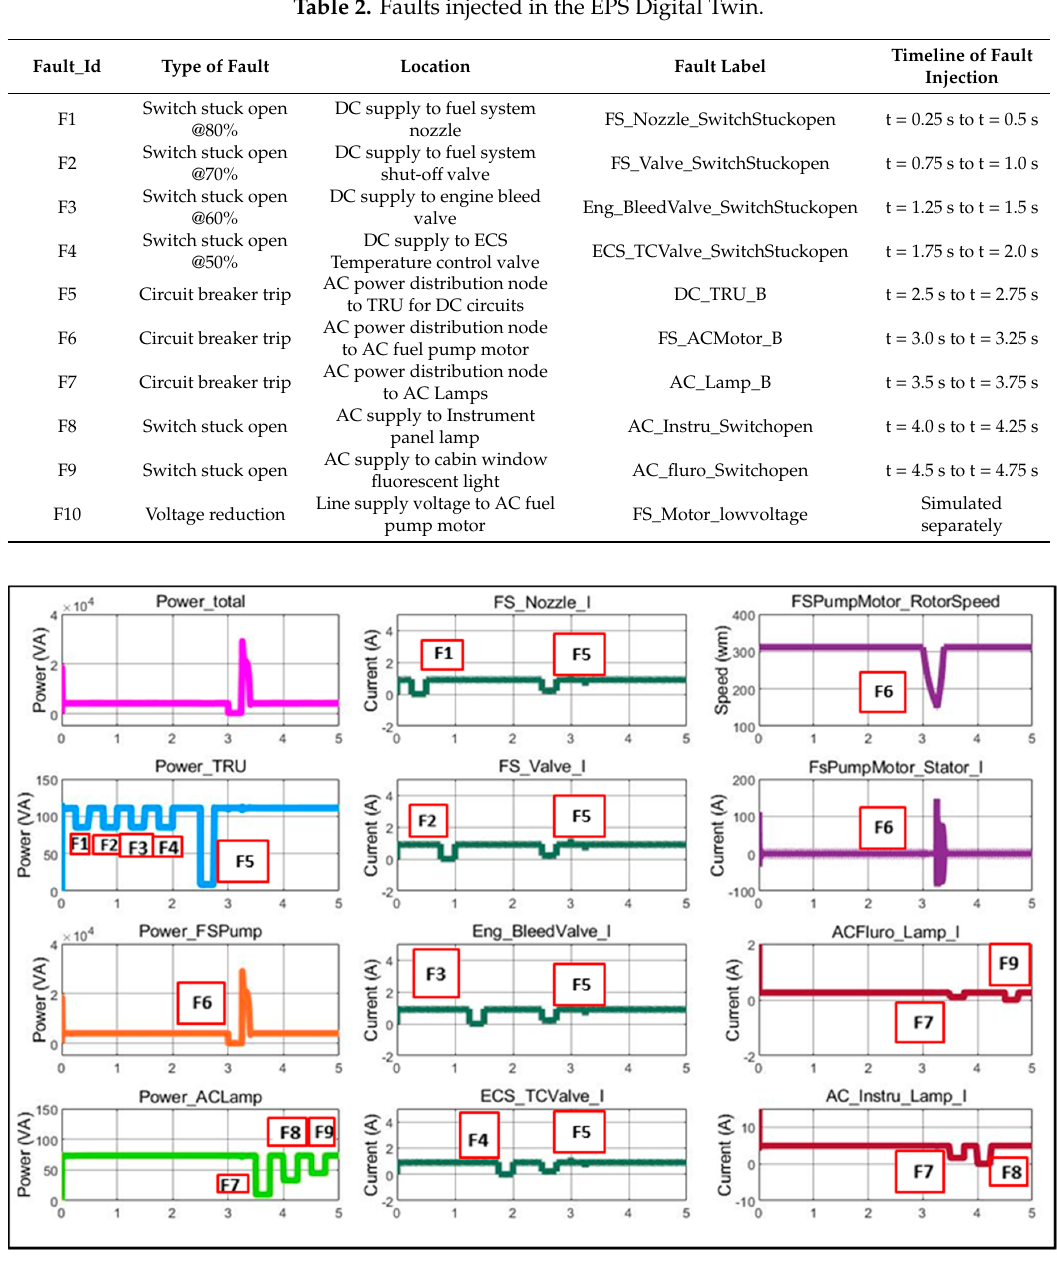
Figure 5. EPS performance during various fault scenarios (faults F1, F2, ... , F9). Left column: Total power generated and power consumed by DC TRU, FS Pump, and AC Lamp (kVA). Middle column: Currents at DC Loads. Right column, top two plots: FS Pump characteristics. Right column, bottom two plots: Currents at AC Lamps.